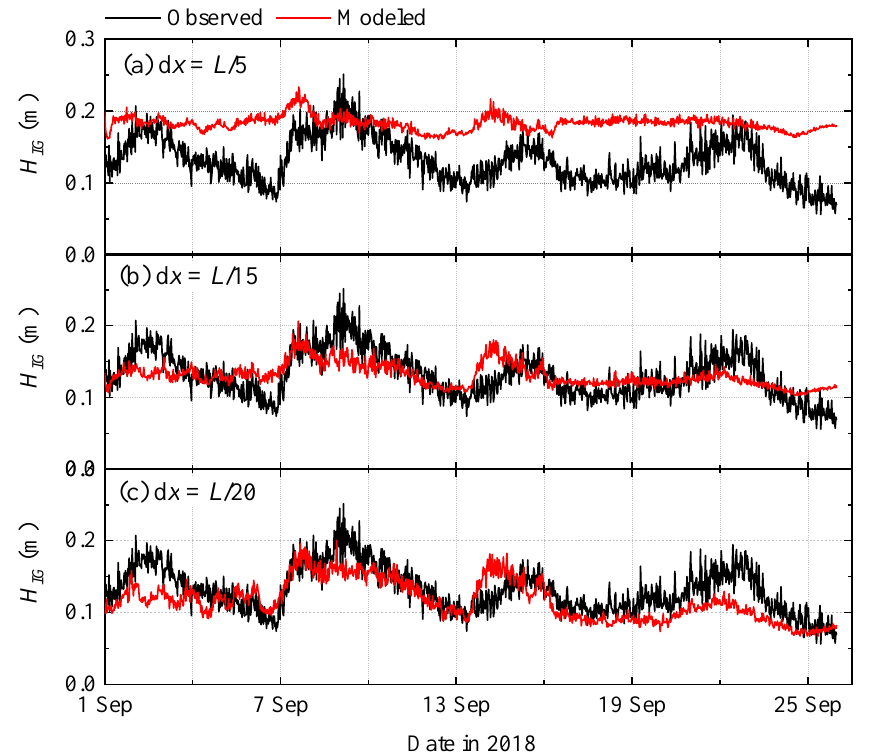
H 1–25 September 2018, at the location of sensor IG